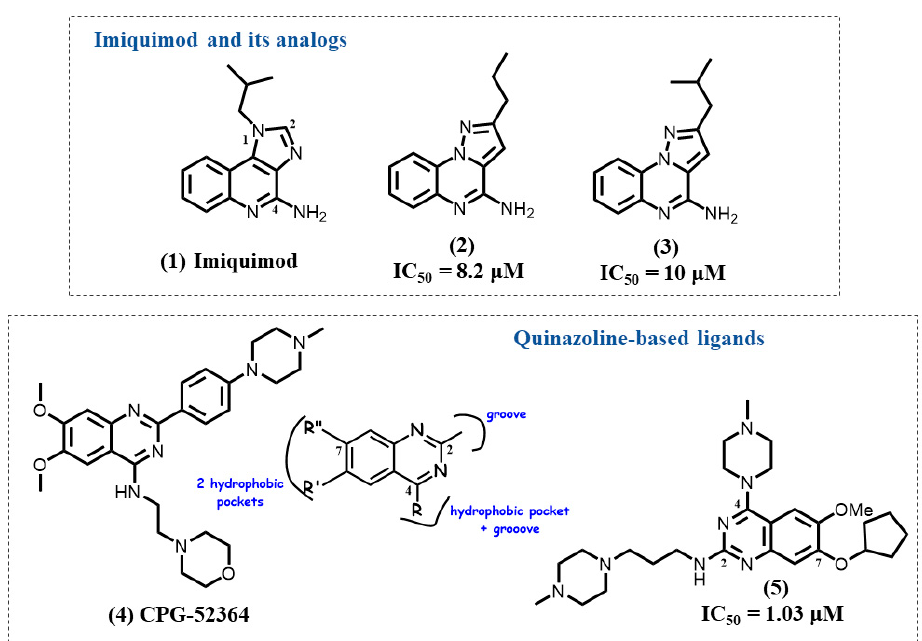
Figure 2. Imiquimod analogs and quinazoline derivatives.